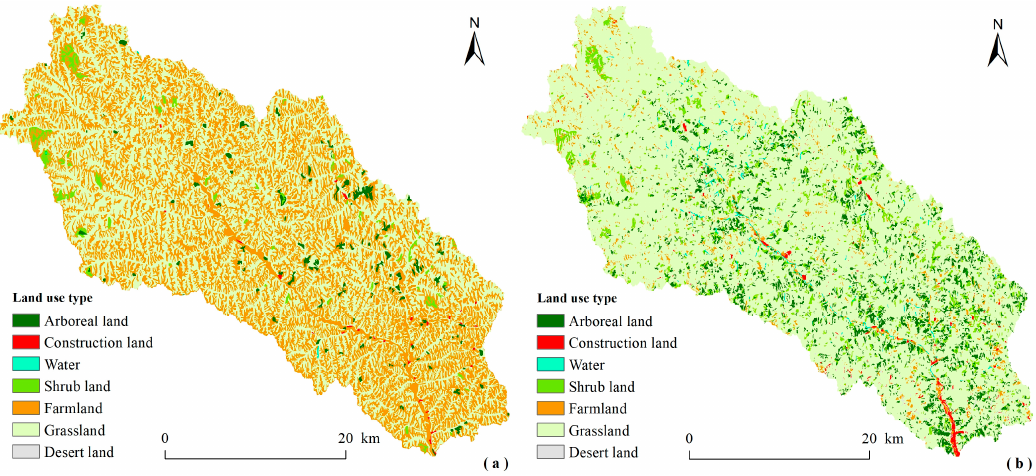
Figure 3. Land use map of the Ansai Watershed in 2000 ( a ) and in 2015 ( b ).